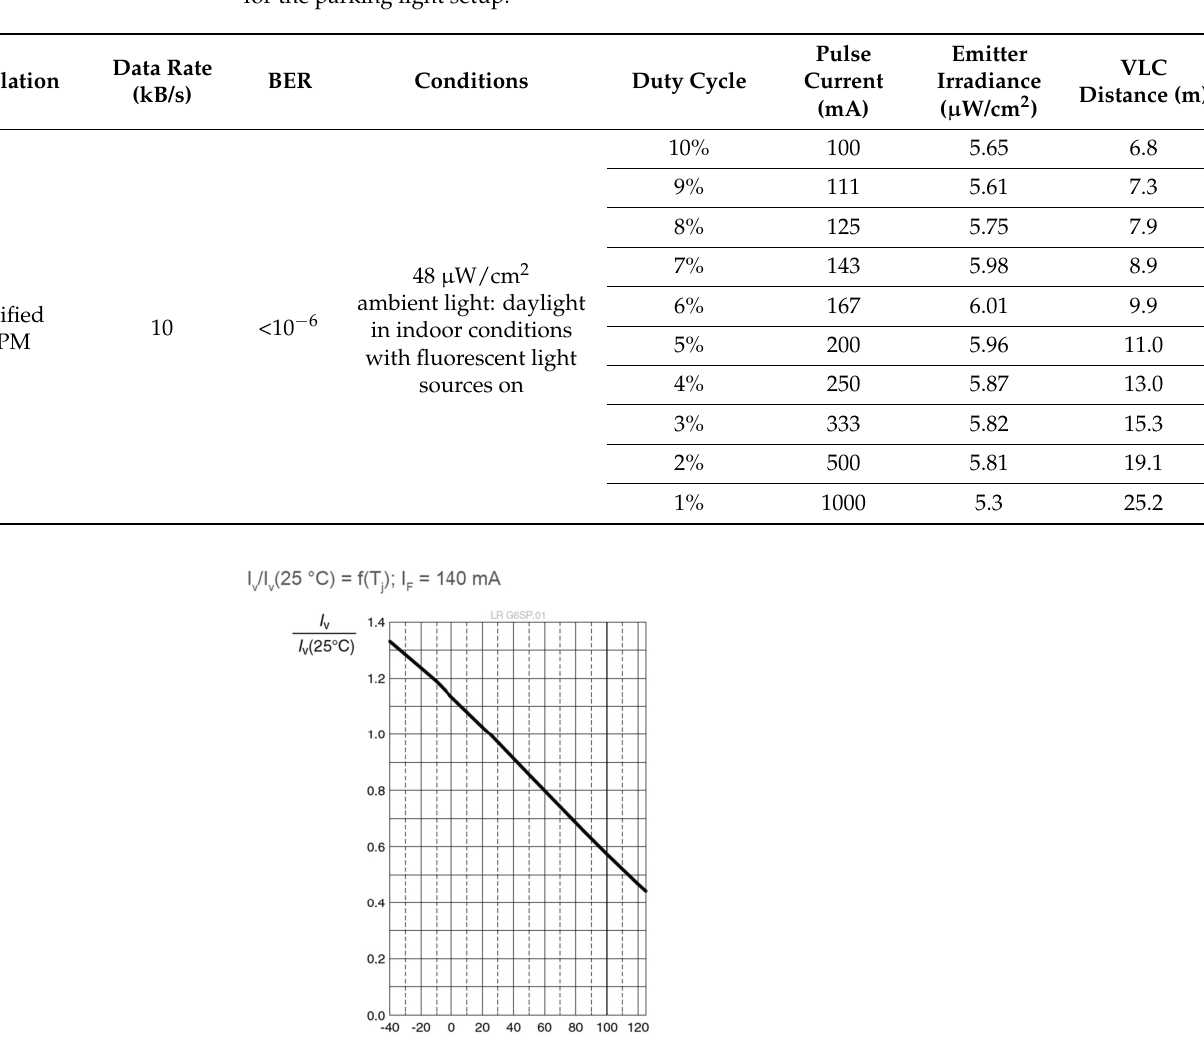
Table 7. Summary of the experimental results showing the viability of the range increasing mechanism for the parking light setup.